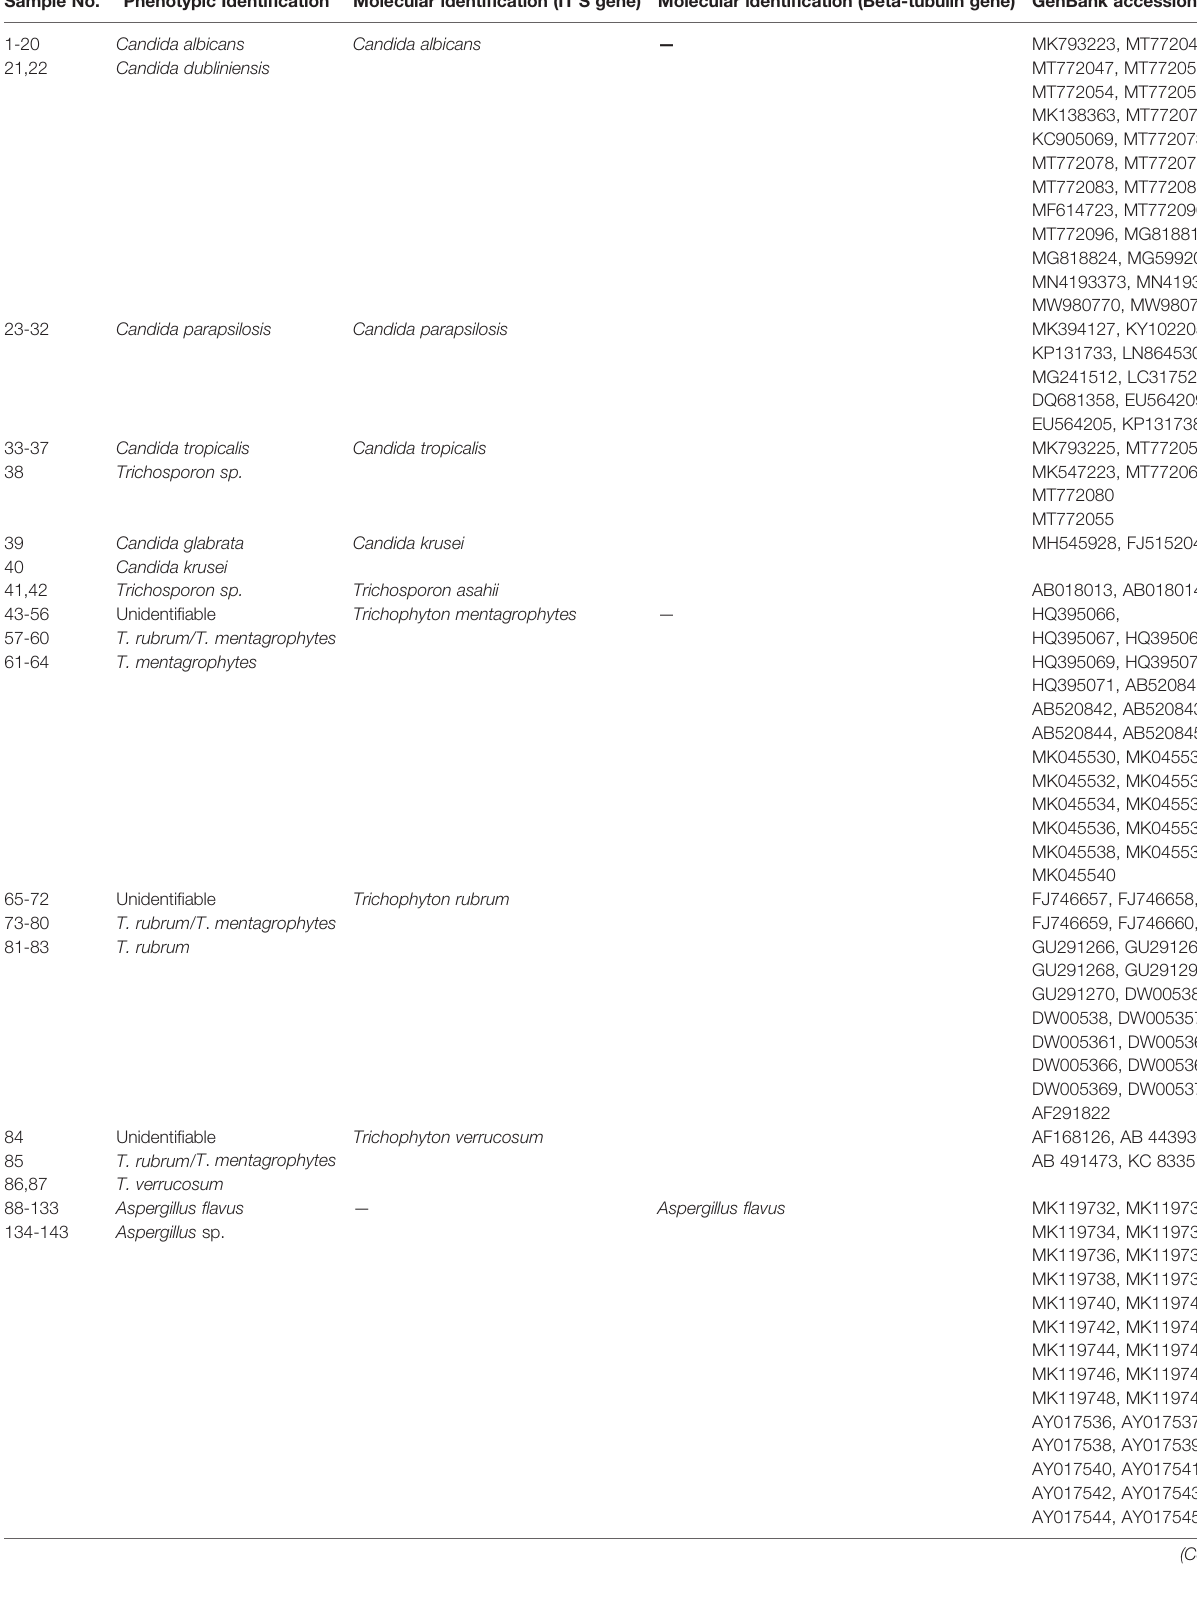
TABLE 3 | Phenotypic and molecular identi fi cation data for 179 isolates included in this